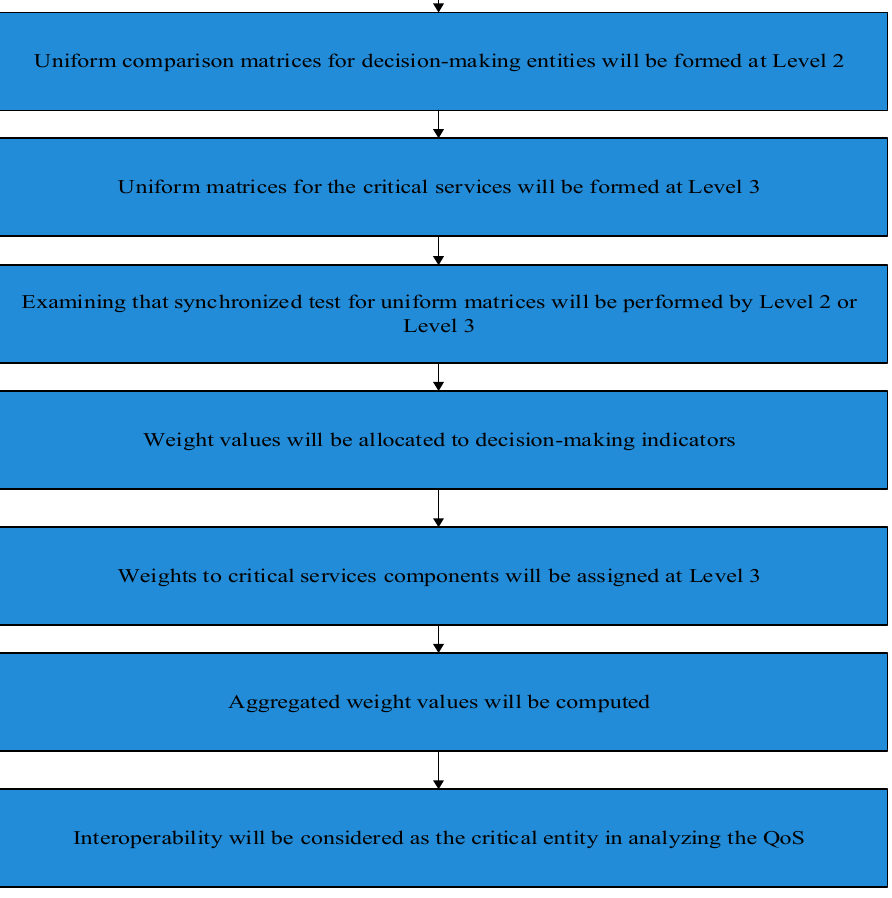
Figure 3. Flowchart of the proposed FSIRA for CPS based connected healthcare.